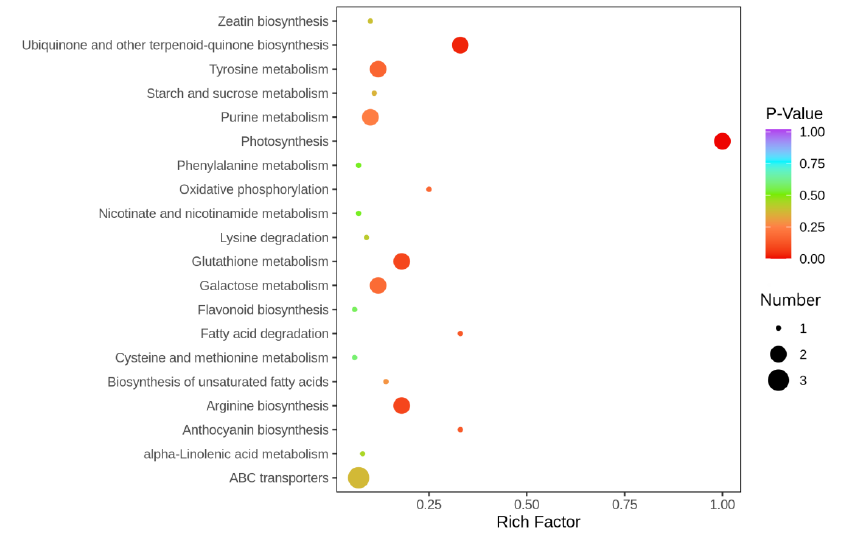
Figure 3. KEGG enrichment map of the differentially accumulated metabolites between P. amarus bamboo shoots grown under shading treatment and normal growing conditions.